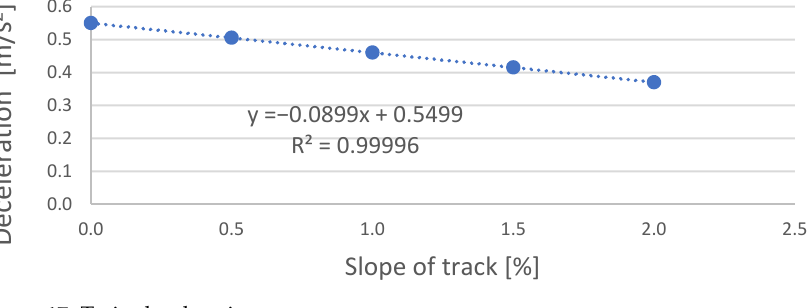
Figure 17. Train deceleration.